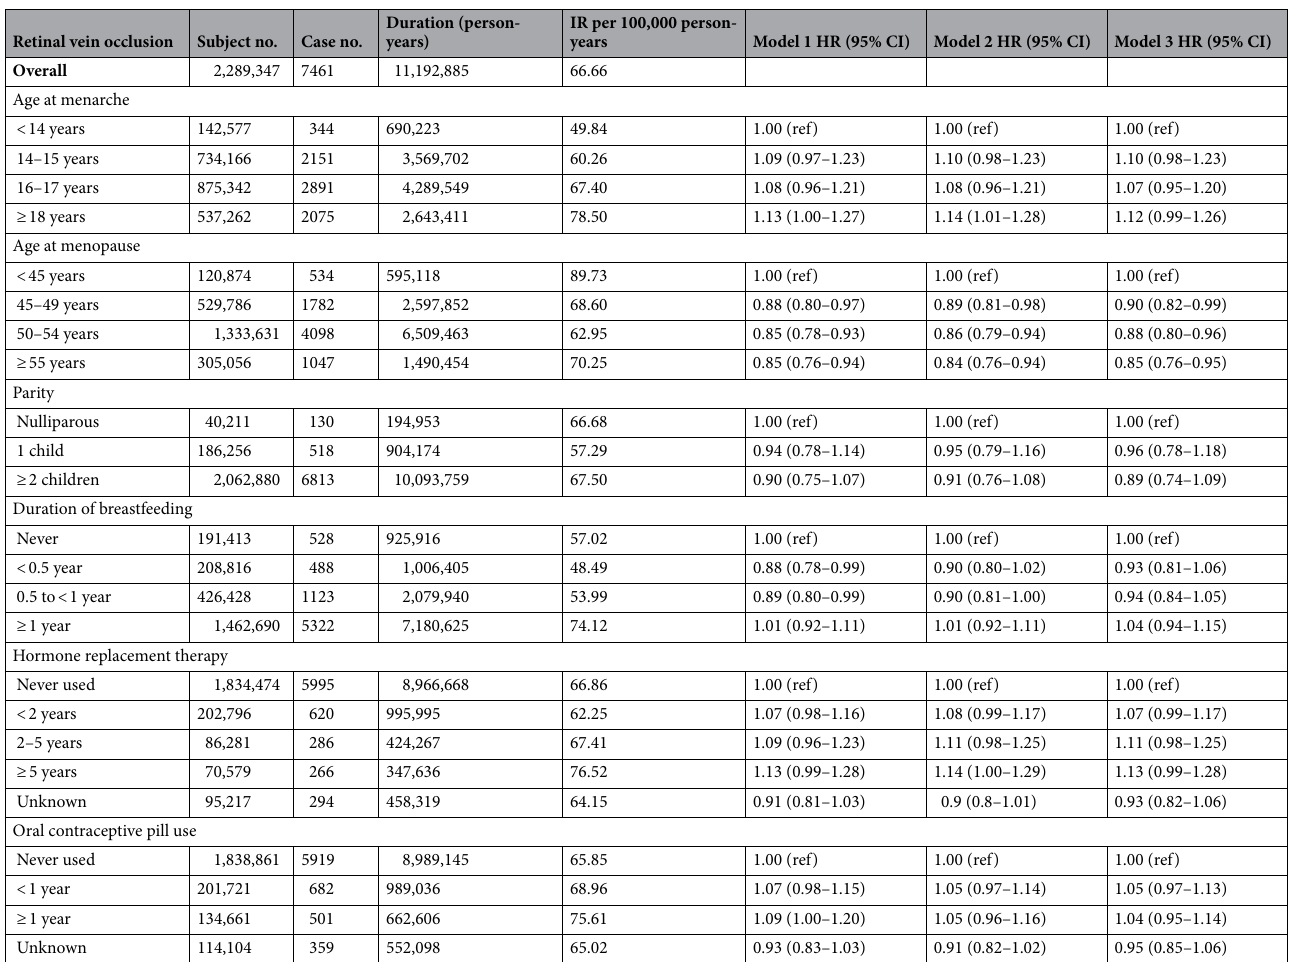
Table 2. Hazard ratios and 95% confidence intervals for development of retinal vein occlusion in postmenopausal women according to female reproductive factors. Model 1: adjusted for age. Model 2: adjusted for age, income level, systemic comorbidities (hypertension, diabetes mellitus, dyslipidemia, stroke, heart disease, and chronic kidney disease), and behavioral factors (smoking history, drinking habit, physical activity, body mass index). Model 3: adjusted for age, income level, systemic comorbidities, behavioral factors, and female reproductive factors (age at menarche, age at menopause, parity, breastfeeding, hormone replacement therapy, oral contraceptive pill). IR, incidence rate; HR, hazard ratio; CI, confidence